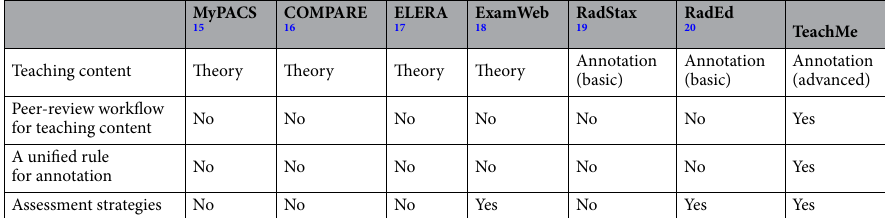
Table 1. Comparison of main web-based systems for radiology education.